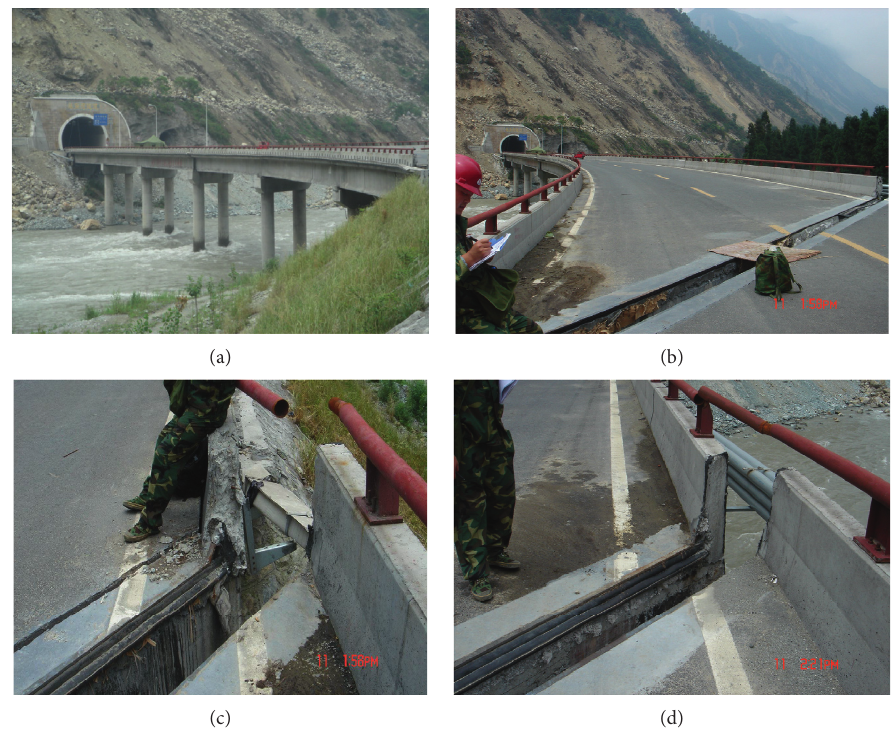
Figure 4: Photographs of the Duxiufeng Bridge after the 2008 Wenchuan earthquake. (a) Photographs of the bents. (b) Photographs of the deck. (c) Transverse residual displacement at abutment 0. (d) Transverse residual displacement at bent